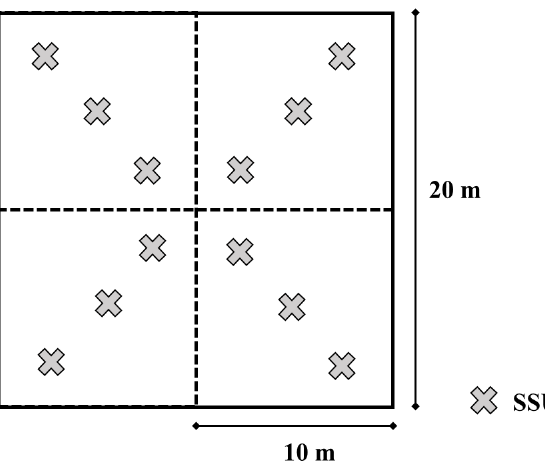
Figure 2. Field measurement protocol for each Elementary Sampling Unit (ESU).